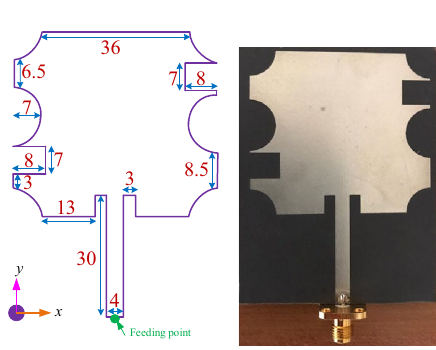
Figure 12. Optimized antenna-2 simulated (left) fabricated (right). Unit is mm.